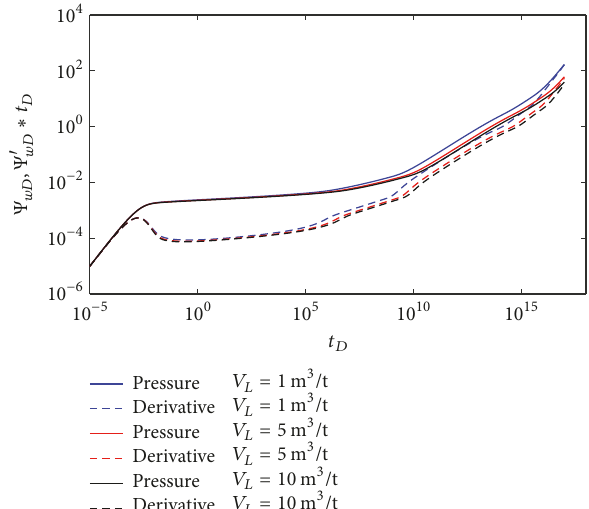
Figure 5: Effect of hydraulic fracture permeability on pressure.